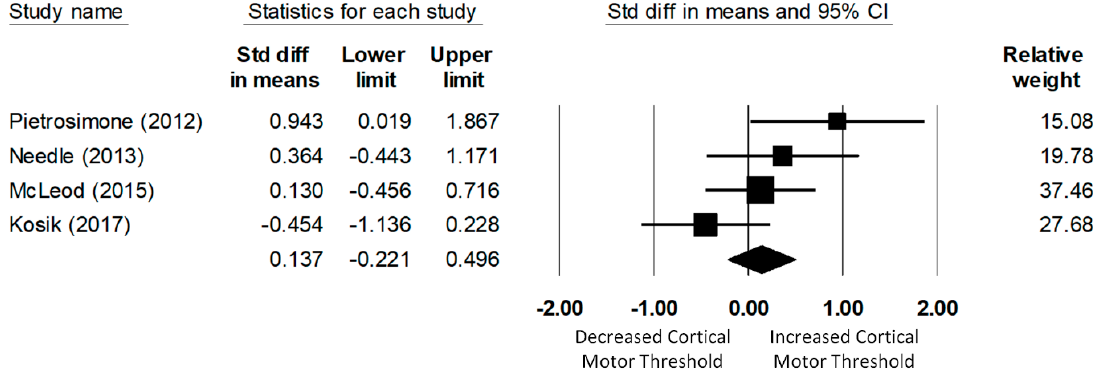
Figure 5. Forest plot illustrating Cohen’s d effect sizes for the fibular longus cortical motor threshold between groups with and without CAI and their 95% confidence intervals.